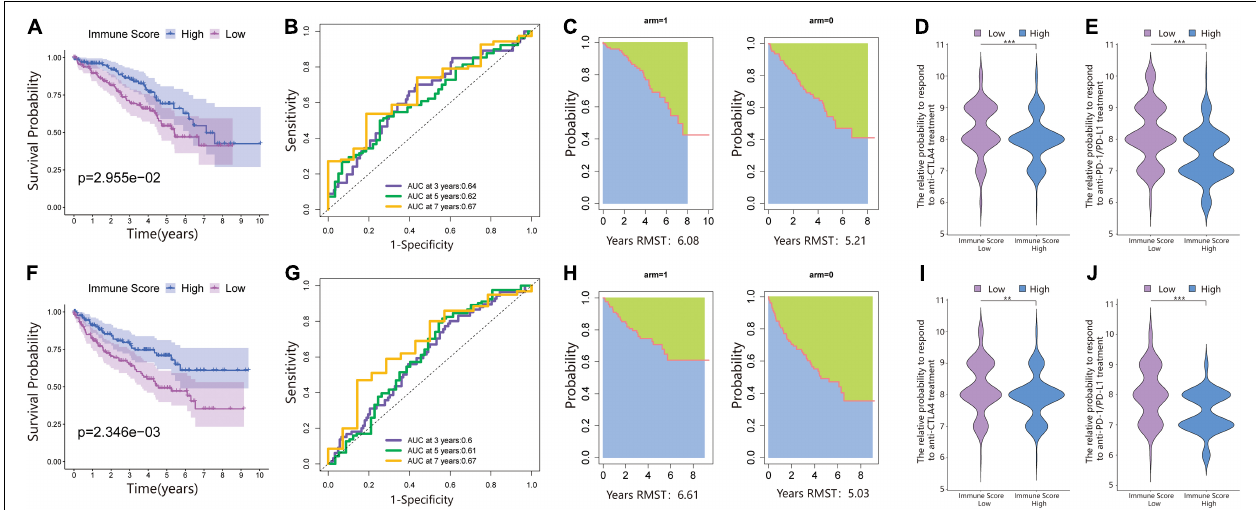
FIGURE 2 | An immune score was constructed in the training set and verified in the validation set. (A) Survival analysis of the ISL group and ISH group in the training set. In these two groups, the Kaplan–Meier curve with a log-rank p -value of 0.030 showed significant survival differences. (B) Time-dependent receiver operating characteristic (ROC) curve analysis of the immune score in the training set. The 3-, 5-, and 7-year area under curves (AUCs) in all samples were 0.64, 0.62, and 0.67, respectively. (C) The restricted mean survival (RMS) curve for the immune scores was plotted in the training set. In the ISL and ISH groups, the RSM times were 6.08 and 5.21, respectively. The blue part represents the RMS time, and the green part represents the restricted mean time lost (RMTL). (D,E) The relative probabilities of anti-cytotoxic T lymphocyte-associated protein 4 (CTLA4) and anti-programmed cell death protein 1 (PD-1)/programmed death-ligand 1 (PD-L1) treatment between the immune score low (ISL) and ISH groups in the training set. (F) Survival analysis of the ISL group and ISH group in the testing set. In these two groups, the Kaplan–Meier curve with a log-rank p -value of 0.002 showed significant survival differences. (G) Time-dependent ROC curve analysis of the immune score in the testing set. The 3-, 5-, and 7-year AUCs in all samples were 0.60, 0.61, and 0.67, respectively. (H) The RMS curve for immune scores was plotted in the testing set. In the ISL and ISH groups, the RSM times were 6.61 and 5.03, respectively. The blue part represents the RMS time, and the green part represents the restricted mean time lost (RMSL). (I,J) The relative probabilities of anti-CTLA4 and anti-PD-1/PD-L1 treatment between the ISL and ISH groups in the testing